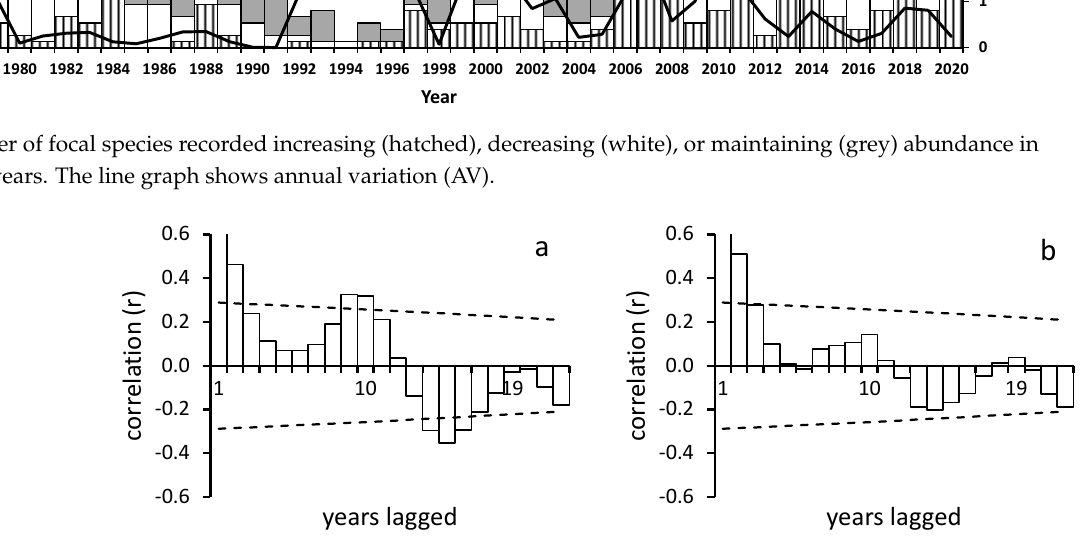
Figure 6. Time series of the standardised annual abundance of focal species on the gravel plain. Members of groups A–F correlate (r = 0.47–0.89, p < 0.001) with other group members and are linked with cluster analysis.